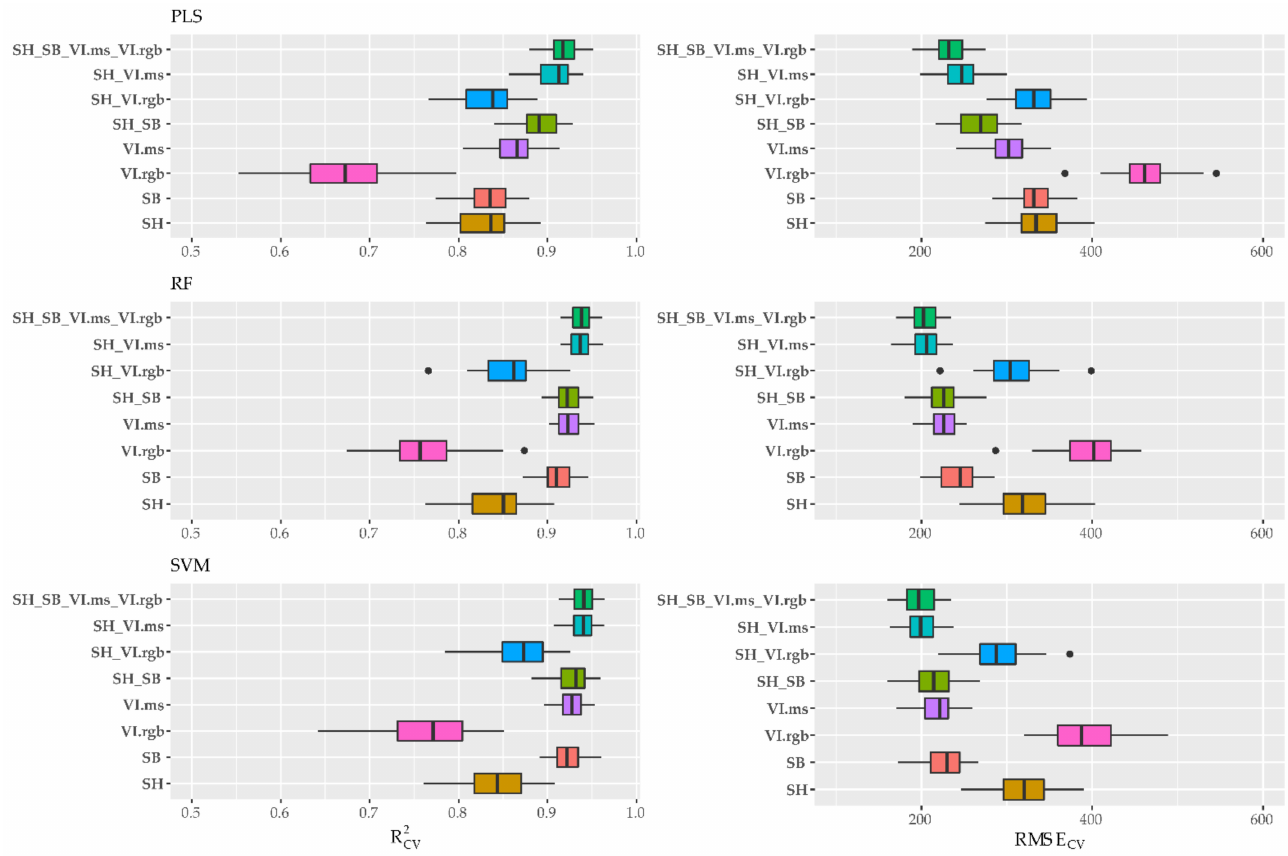
Figure 12. Box and whisker plot of R 2 CV and RMSE CV (kg ha − 1 ) of all resamples of RF, SVM, and PLS models for DMY prediction (SH: sward height metrics. SB: single bands, VI.rgb: RGB indices, VI.ms: VNIR